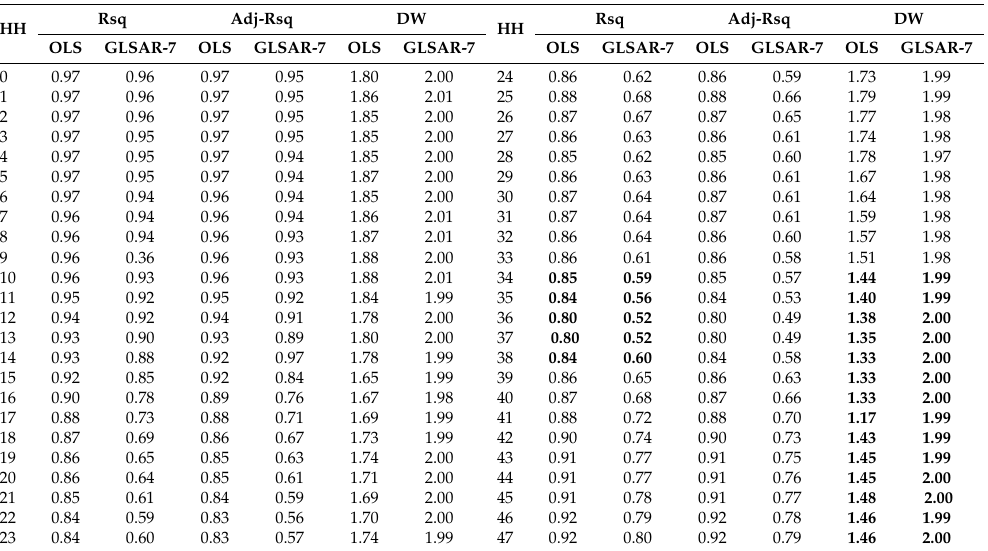
Table 3. Model description paramters: GLSAR-7 (Scenario